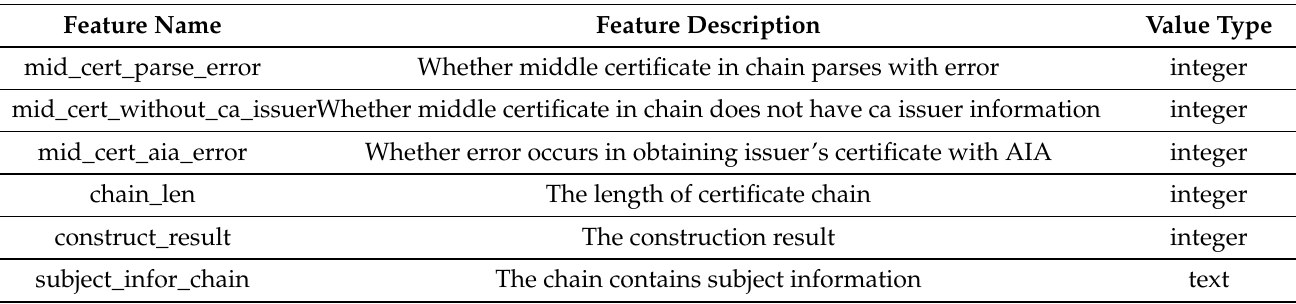
Table 6. Details of features from certificate chain